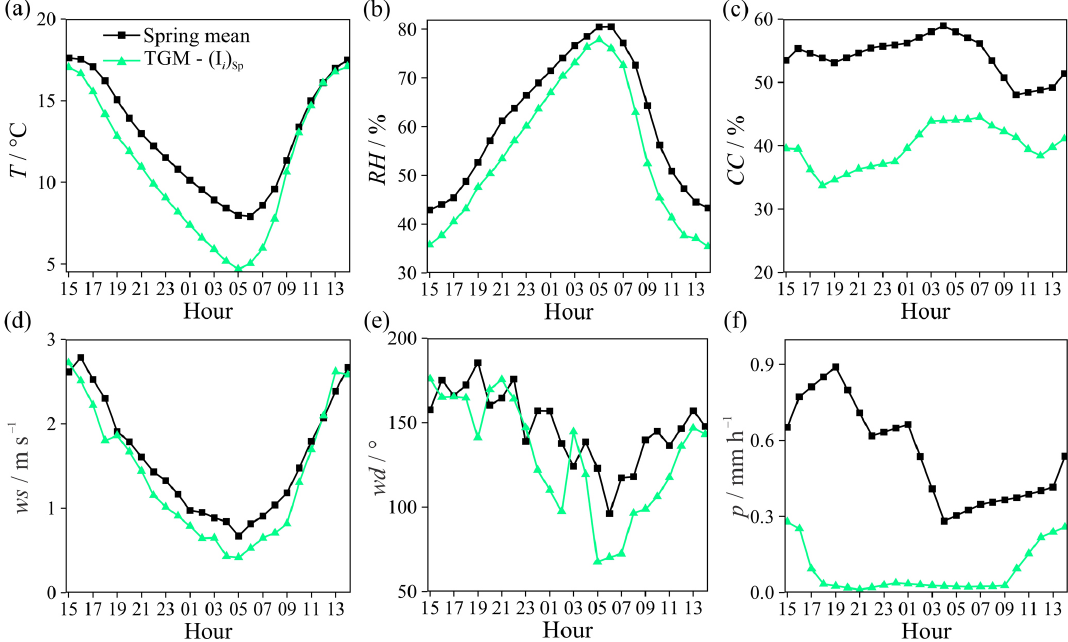
Figure 14. Diurnal composites, based on hourly means, of (a) air temperature, (b) relative humidity, (c) cloud cover, (d) wind speed, (e) wind direction, and (f) precipitation, for spring mean, and persistent temperature inversion events detected in spring by the TGM. No persistent temperature inversion events were detected by the RBM this season.